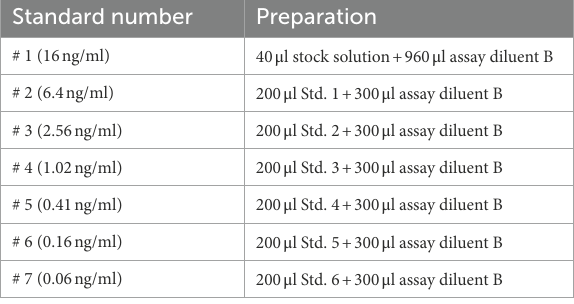
TABLE 1 Preparation of the standard curve. Standard number